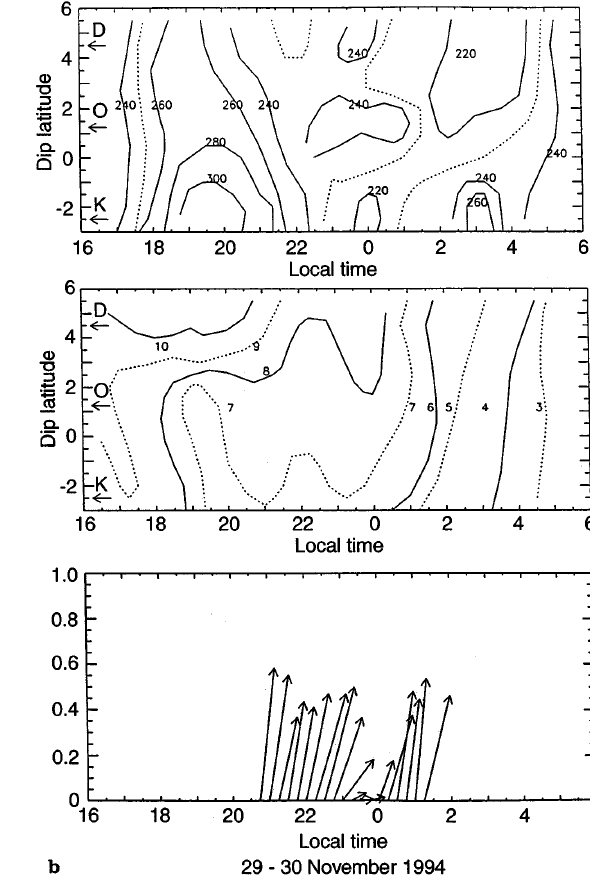
horizontal wind observed with the Fabry-Perot interferometer. a For November 28–29 1994; b for November